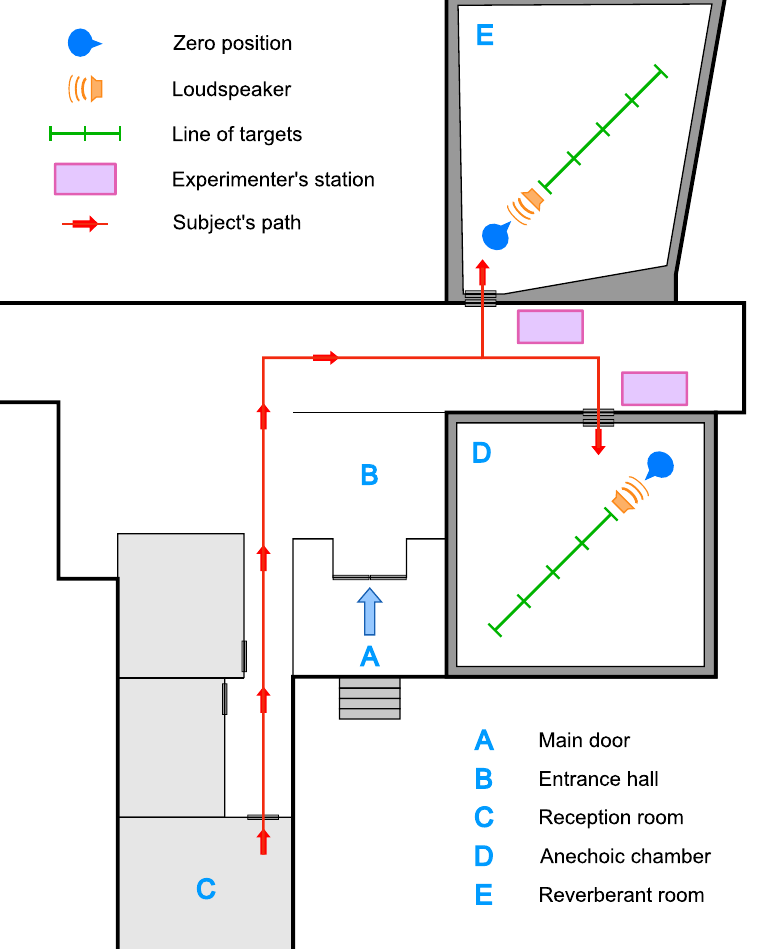
Figure 1. Schematic diagram of the experimental set-up at the Laboratorio de Acústica y Luminotecnia: It can be observed the reverberant room (E), the anechoic chamber (D), the path walked by the subjects (with eyes covered) during the experiments since they were received (B) to the reception room (C, where they were debriefed) and to both testing rooms (red line and arrows). Also shown are the experimental stations and the layout of the experimental set-up in both